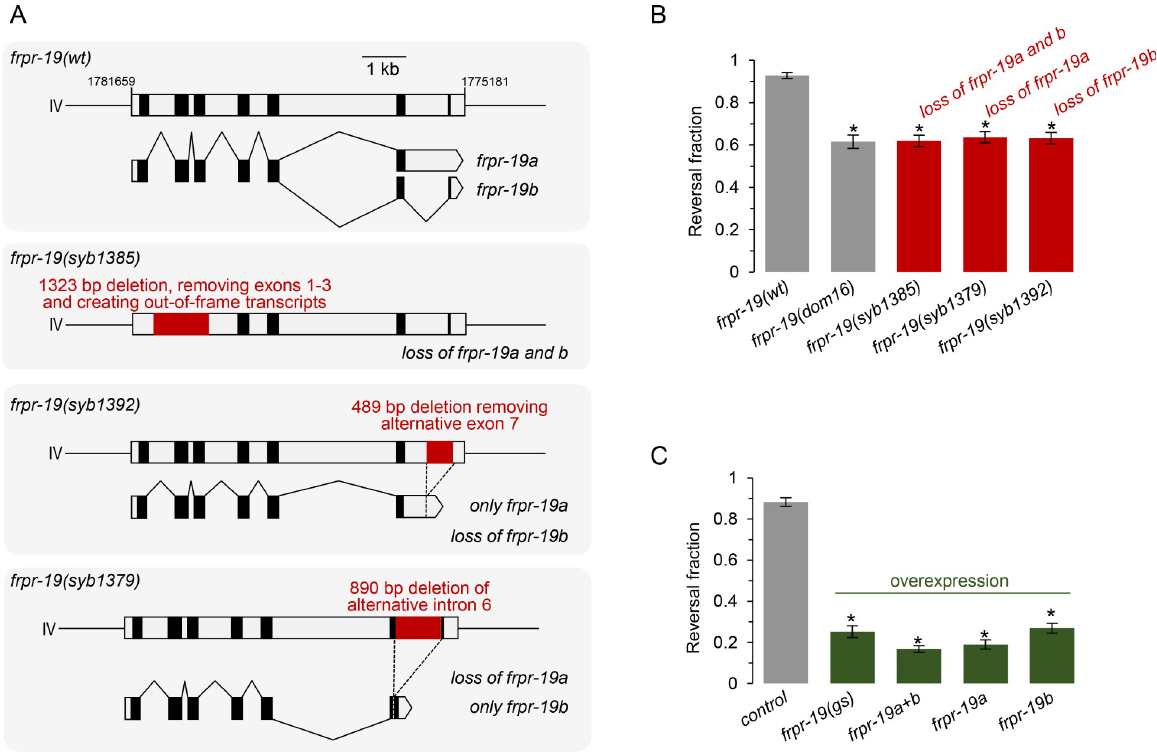
Fig 2. Both FRPR-19A/B loss and their overexpression impair FLP neuron-dependent reversals. (A) Schematic of wild type and engineered frpr-19 mutations showing, for each, the genomic locus (top) and the resulting transcript (bottom). (B, C) Fraction of FLP optogenetic stimuli producing a reversal response, scored as in Fig 1, in the indicated frpr-19 mutants (B) and in frpr-19(wt) animals containing overexpression transgenes as multi-copy extrachromosomal arrays (C): frpr-19(gs) (genomic sequence); frpr-19a+b (cds constructs for both a and b isoforms); frpr-19a (cds construct for the a isoform); frpr-19b (cds construct for the b isoform). � , p < .001 versus wild type control by Bonferroni contrasts.